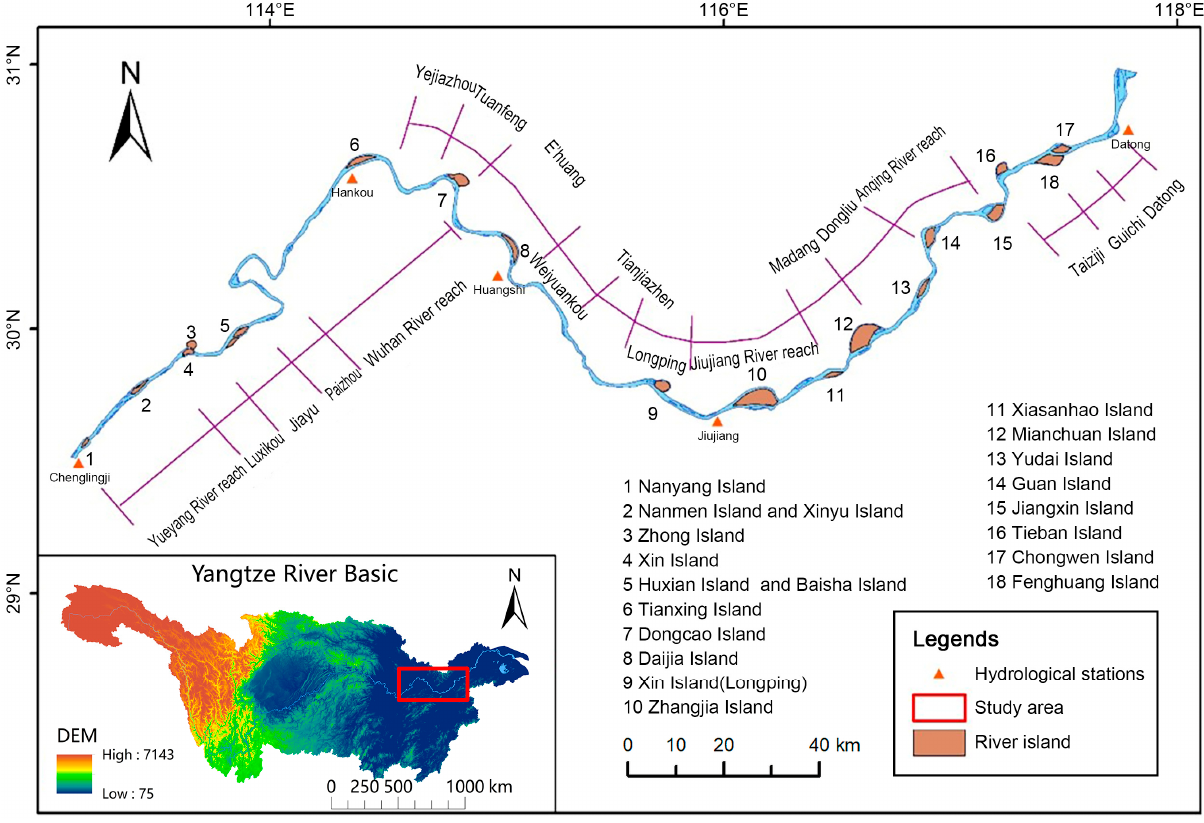
Figure 1. Location of the study